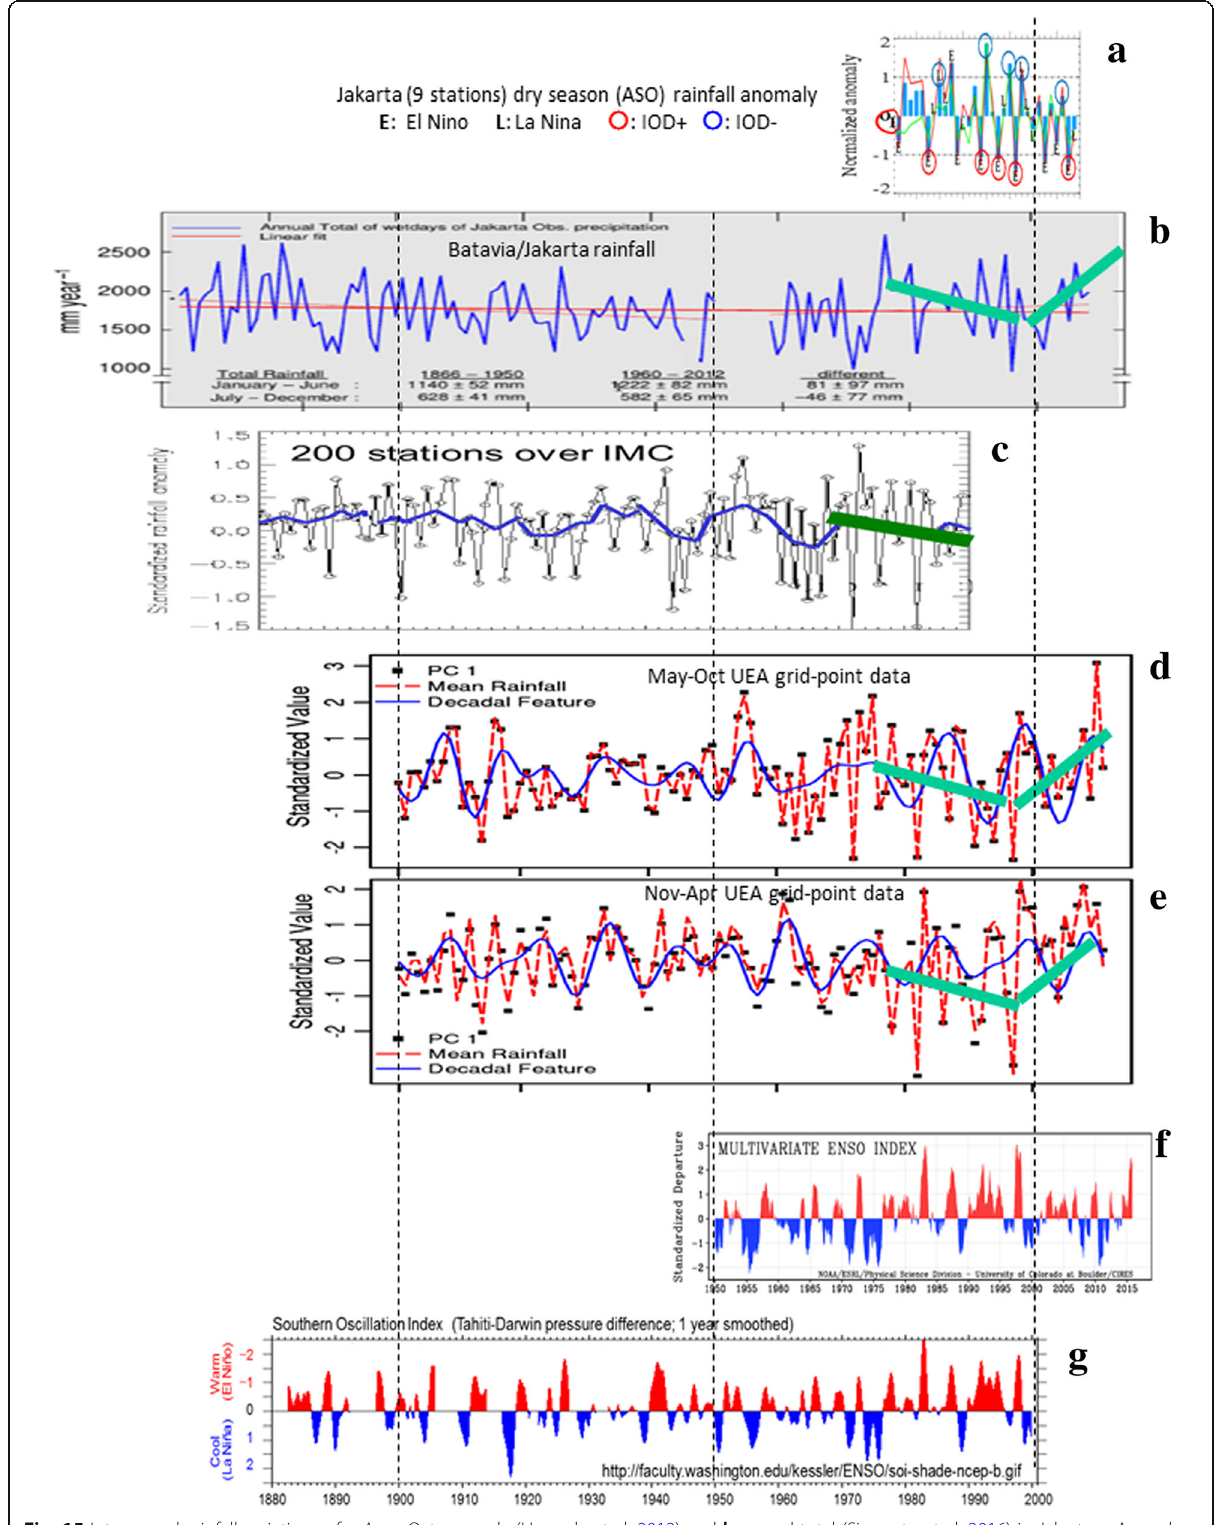
Fig. 15 Interannual rainfall variations of a Aug − Oct anomaly (Hamada et al. 2012) and b annual total (Siswanto et al. 2016) in Jakarta. c Annual (Hamada et al. 2002), d May − Oct and e Nov − Apr (Yanto et al. 2016) anomalies over the IMC, in comparison with f multivariate ENSO (https:// www.esrl.noaa.gov/psd/enso/mei/) and g original SO (http://faculty.washington.edu/kessler/ENSO/soi-shade-ncep-b.gif)